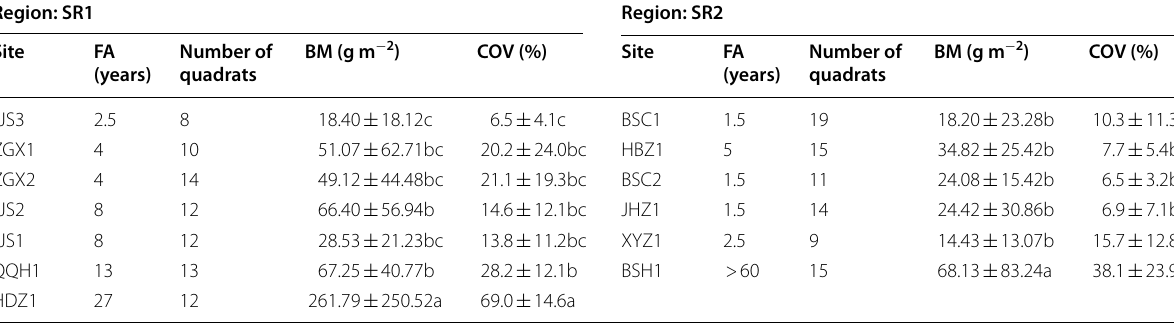
FA, BM, and COV represent formation age of RCSs, biomass and coverage of BSCs, respectively; BM and COV data are expressed in mean the same study region, different lowercase letters represent the significant difference ( P < 0.05) in biomass or coverage among various sites